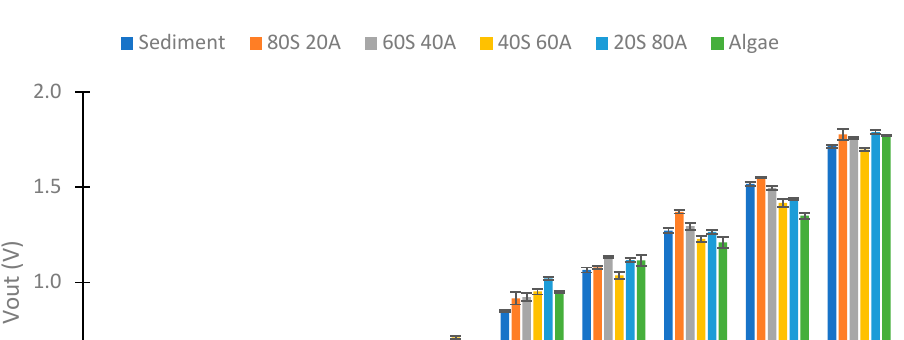
Figure 9. Observed versus predicted NTU values model.